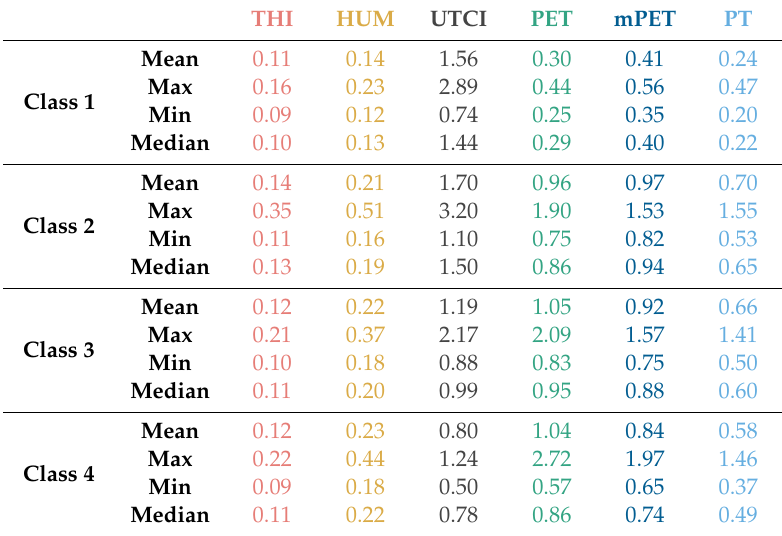
Table 5. Descriptive statistics of the indices’ sensitivity to Wind Speed (WS) under different Global Radiation (GR) conditions. THI (Thermohygrometric Index), HUM (HUMIDEX), UTCI (Universal Thermal Climate Index), PET (Physiologically Equivalent Temperature), mPET (modified PET), PT (Perceived Temperature). THI